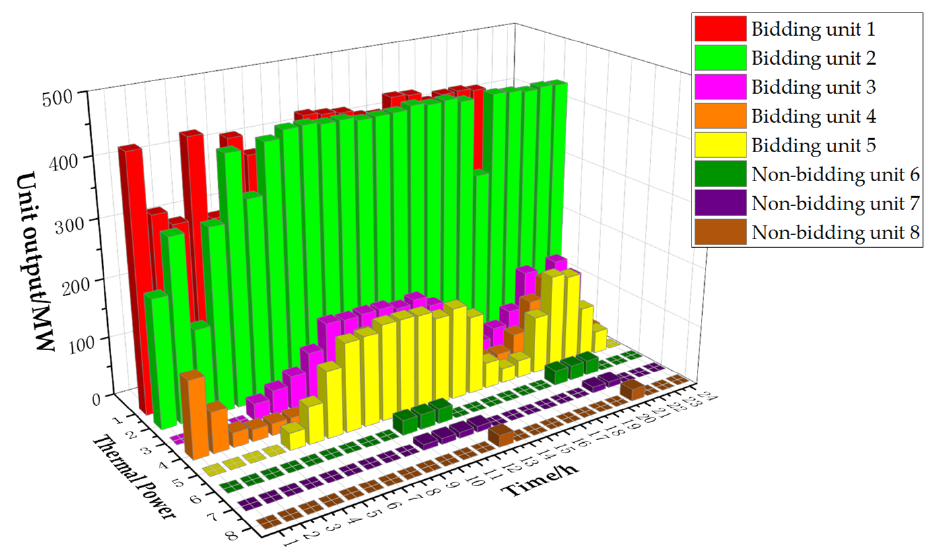
Figure 11. Output of thermal power unit in Case 2.